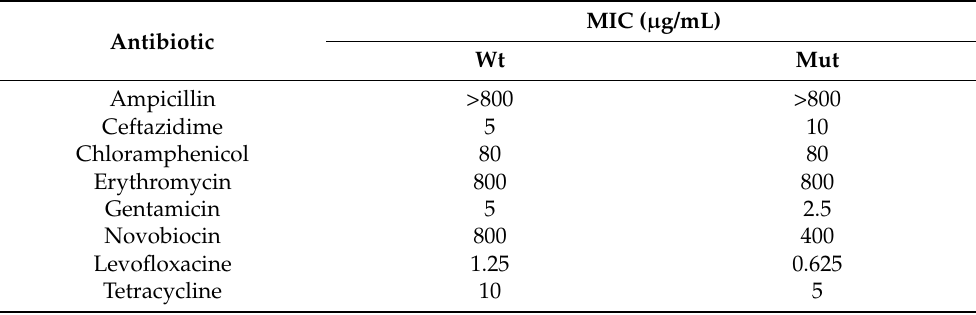
Table 2. Antimicrobial susceptibility profiles of WCS358 wild type and ∆ rclS